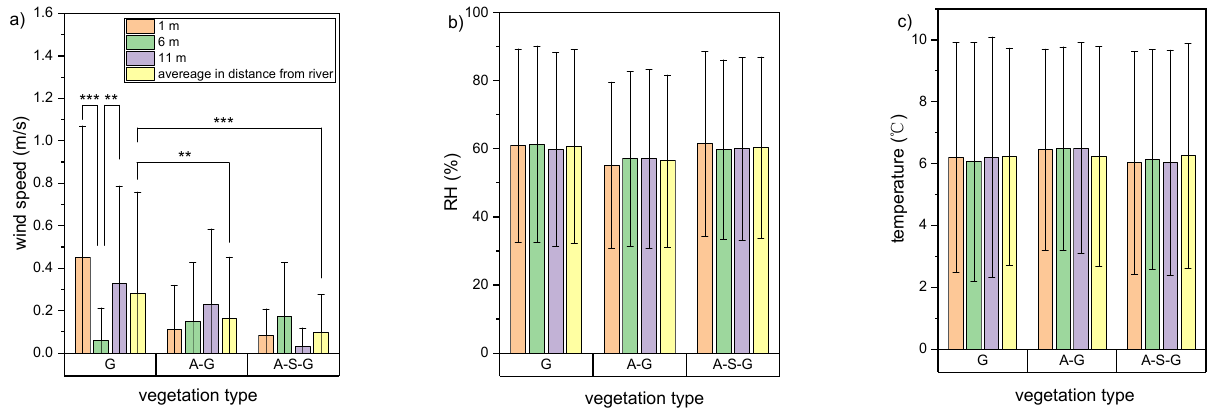
Figure 5. ANOVA results of the ( a ) wind speed, ( b ) relative humidity (RH), and ( c ) temperature in different vegetation types and distances from the river across the entire observation period. ** p ≤ 0.01 *** p ≤ 0.001; Error bar: standard deviation; G: open grassland; AG: arbor-grass woodland; ASG: arbor-shrub-grass woodland. The difference of wind speed as a function of vegetation types and distance from the river explains the spatial distribution of PM concentrations and RP to some extent. The wind speed was the lowest at 6 m from the river along the transect in the G (Figure 5a), causing the lowest RP in the middle the open grassland (Figure 6a,b). The significantly higher wind speed in the G resulted in higher RP than those in the AG and ASG. However, the spatial differences of wind speed in the AG and ASG were not statistically significant. Thus, the spatial differences of PM RP in the AG and ASG will be discussed from other perspectives later.